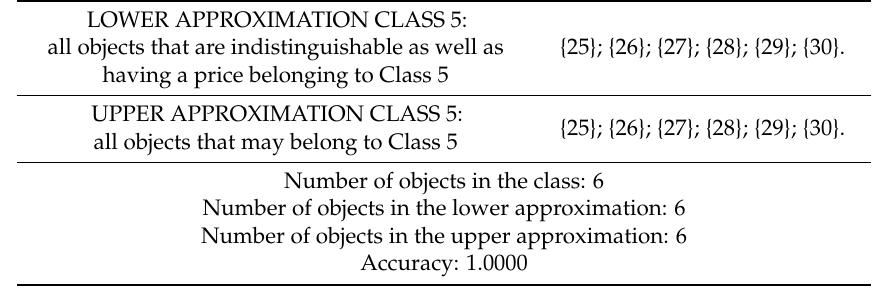
Table 9. Lower and upper approximations for price class